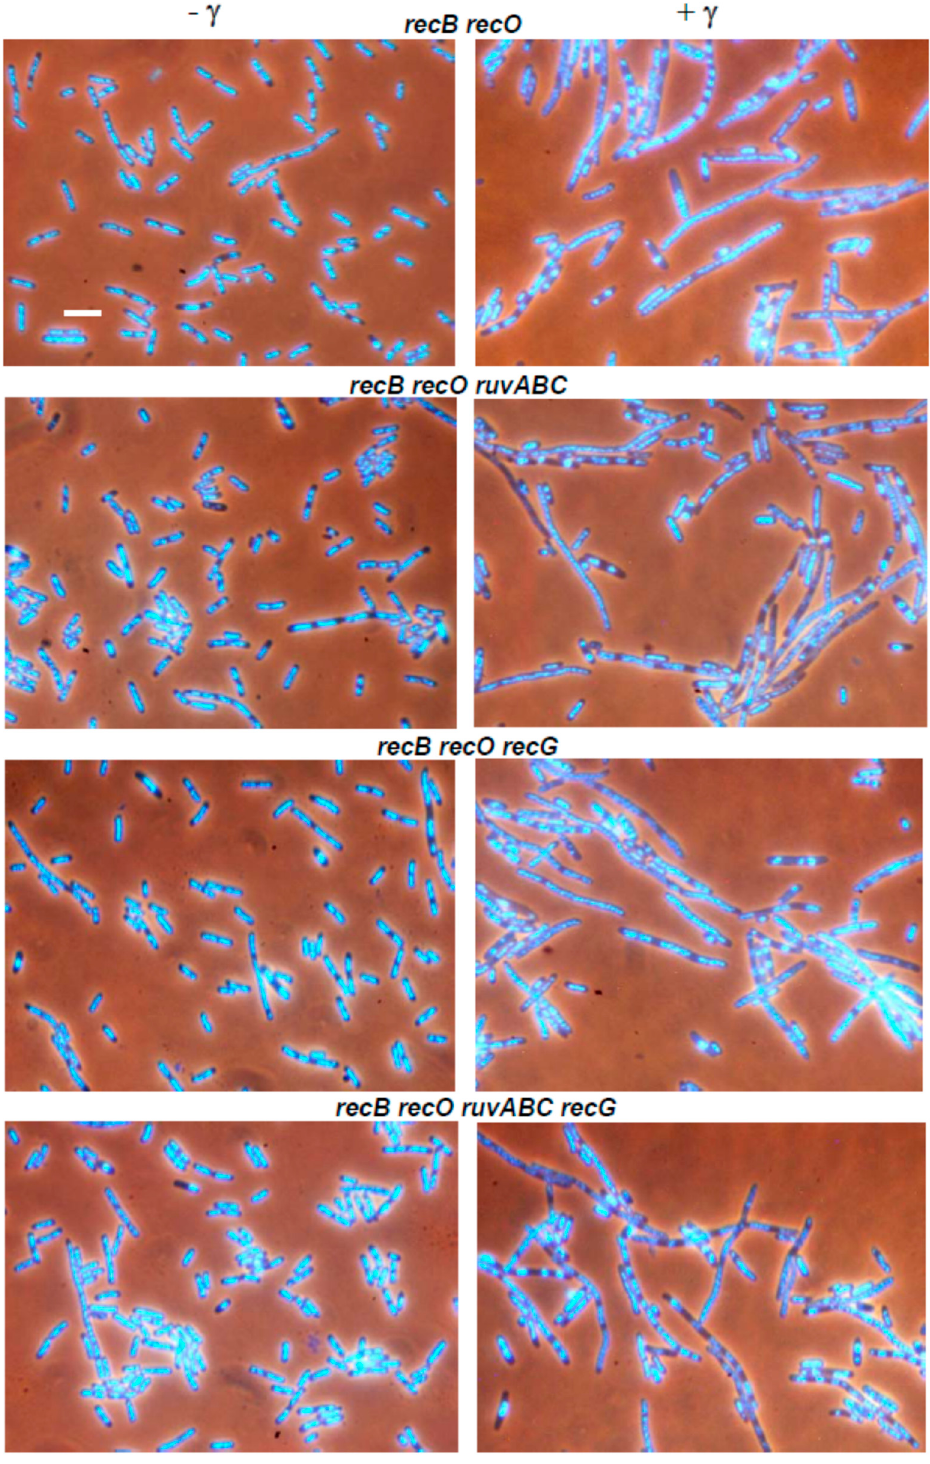
Figure 9. The combination of recB and recO mutations is required for complete suppression of chromosome segregation defects in γ -irradiated ruvABC mutants. Bar, 5 μ m. chromosome segregation defects in γ -irradiated ruvABC mutants. Bar, 5 µ